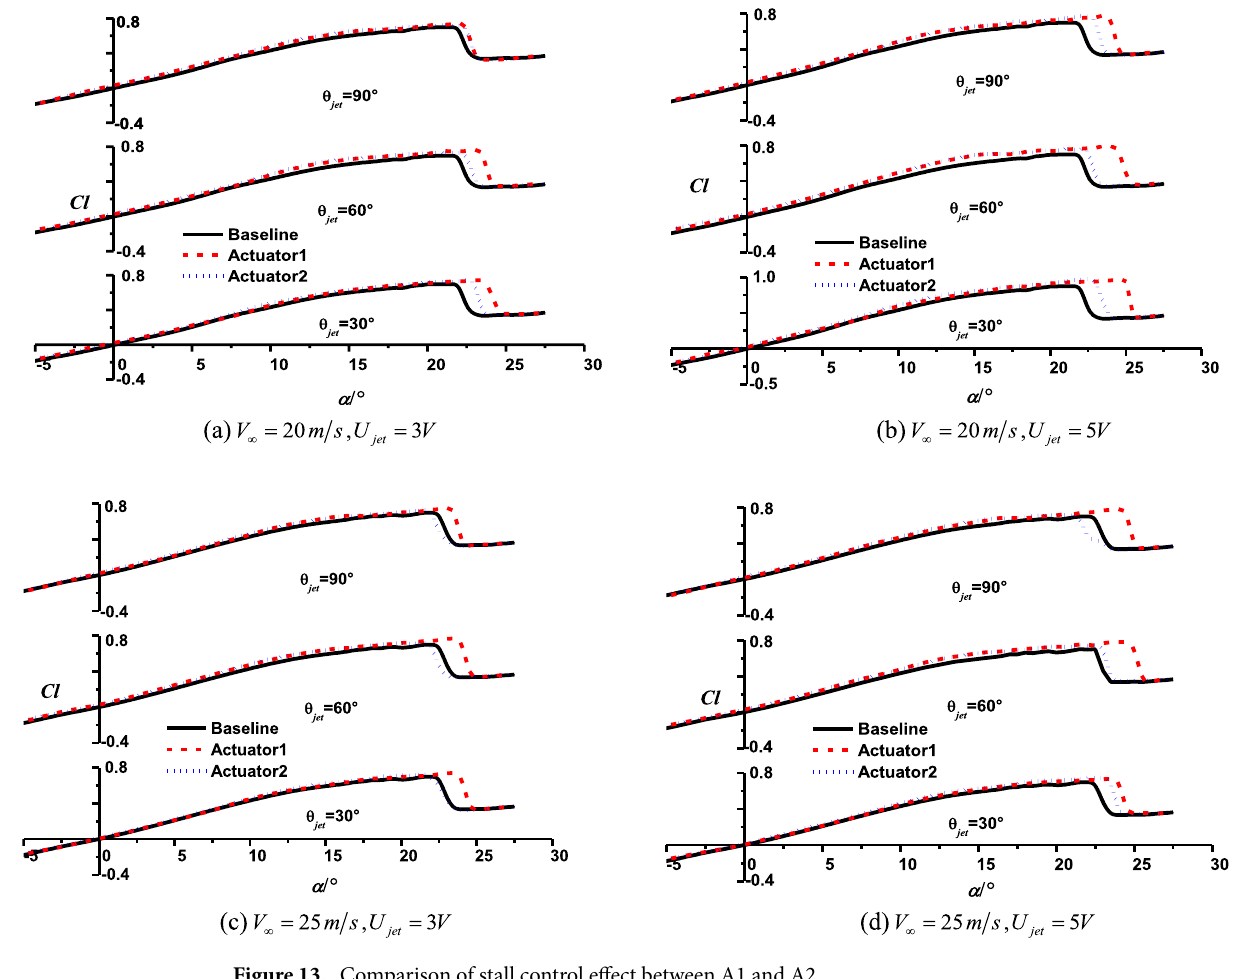
Figure 13. Comparison of stall control effect between A1 and